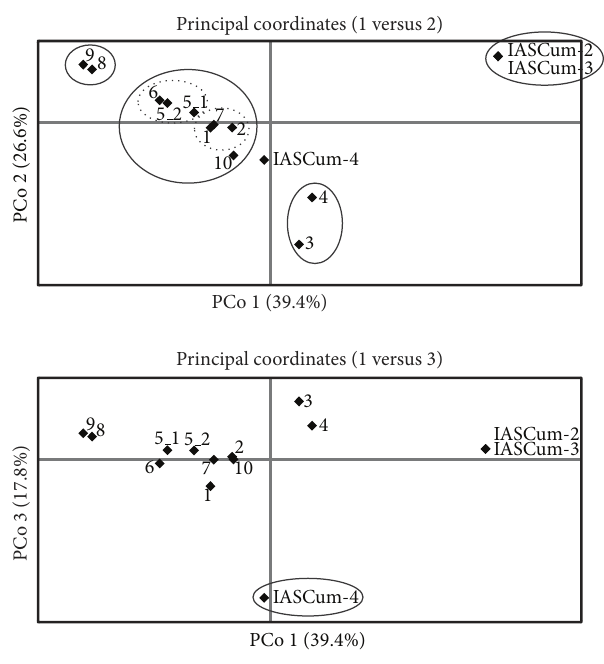
Figure 3: Principal coordinates analysis of pairwise genetic dis- tances among 14 Orobanche cumana populations and subpopu- lations (260 individuals). Primary groups identified with either the 1st versus 2nd axis plot or with the 1st versus 3rd axis plot are highlighted with solid boxes. Populations from Spain (prefix IASCum) are named with their complete name, and populations from Bulgaria (prefix CUMBUL) are named with their number, without prefix.